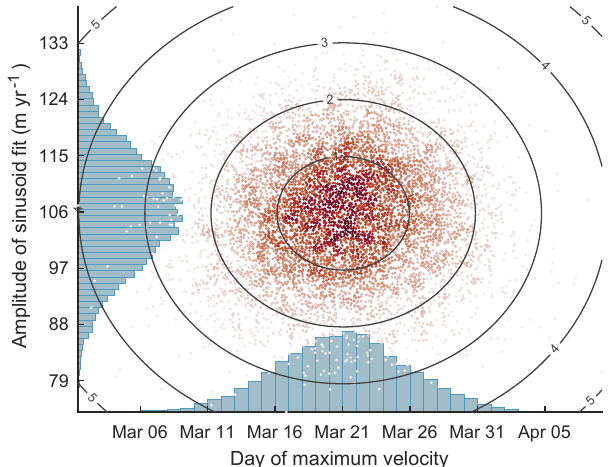
Figure A1. Bootstrap distributions of sinusoid parameters. Scat- tered data show the phase and amplitudes of sinusoids fit by least squares to 10000 random samples of MODIS velocity measure- ments. Red indicates the local density of the scattered data. His- tograms show the distributions of each parameter. Contour lines and axis tick marks indicate 1 standard deviation intervals for each pa-